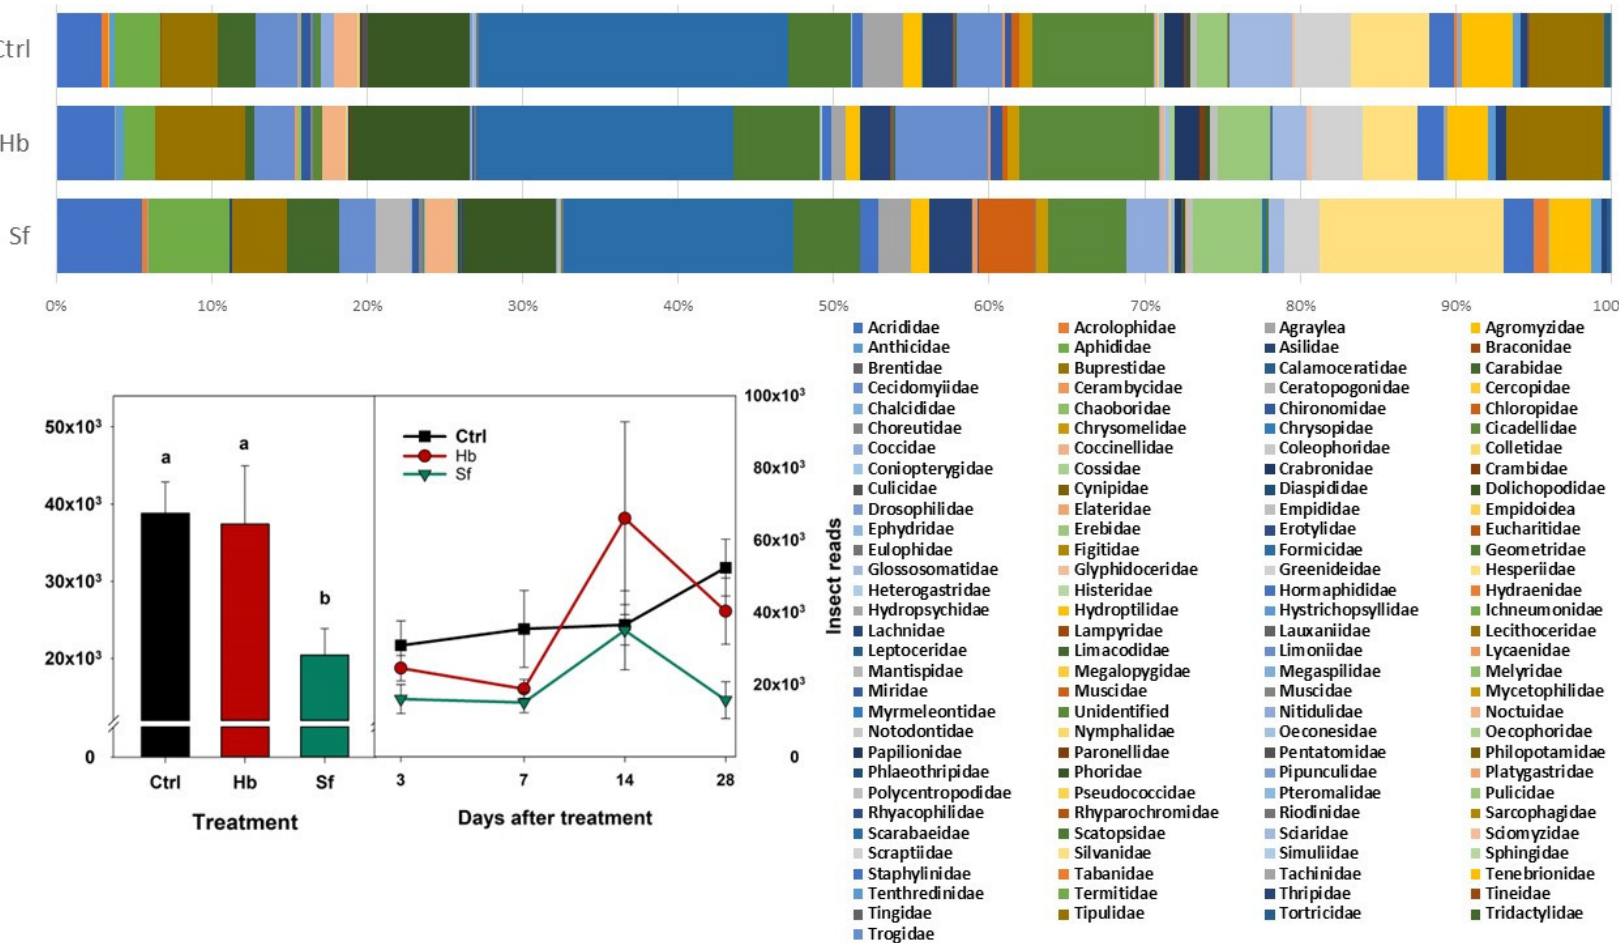
Figure 6. Results of DNA metabarcoding of insect communities. Upper panel: Stacked bar plots showing the relative abundance of insect families ( listed lower right ) detected in a citrus orchard for 28 days following augmentation with Steinernema feltiae (Sf) , Heterorhabditis bacteriophora (Hb) and an untreated control (Ctrl). Lower left: Bar plot of the insect read abundance in each treatment. Lower center: Temporal trends in insect read abundance in the treatments for 28 days following augmentation. Error bars are standard errors of the mean and bars with the same letters do not differ ( p < 0.05).